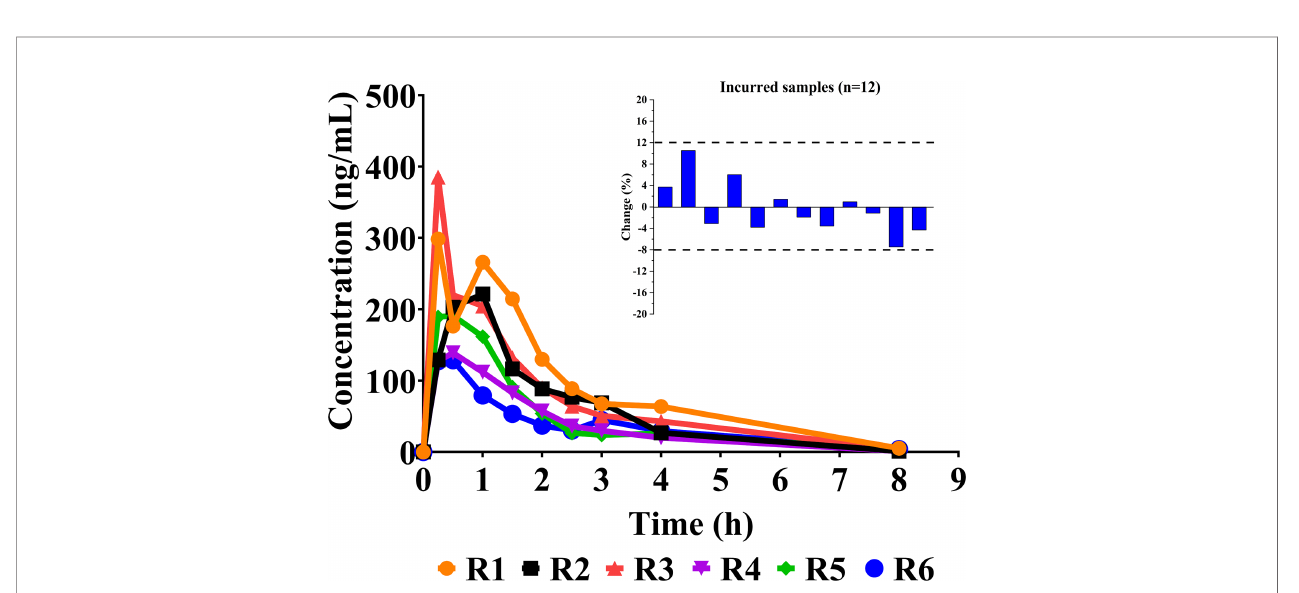
FIGURE 4 | Individual concentration – timecurves of sotorasib in rats after its oral administration at a dose of 10 mg/kg ( n = 6). Also shownisa graphical representation of the results ofincurred sample reanalysis(ISR).